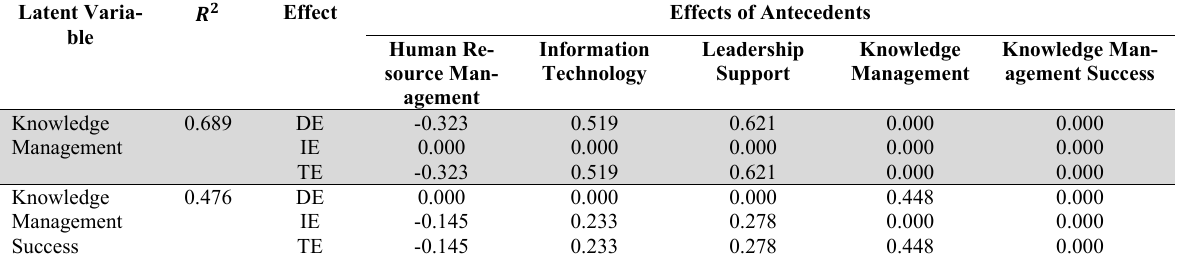
The Effects of the Antecedents Latent Varia-